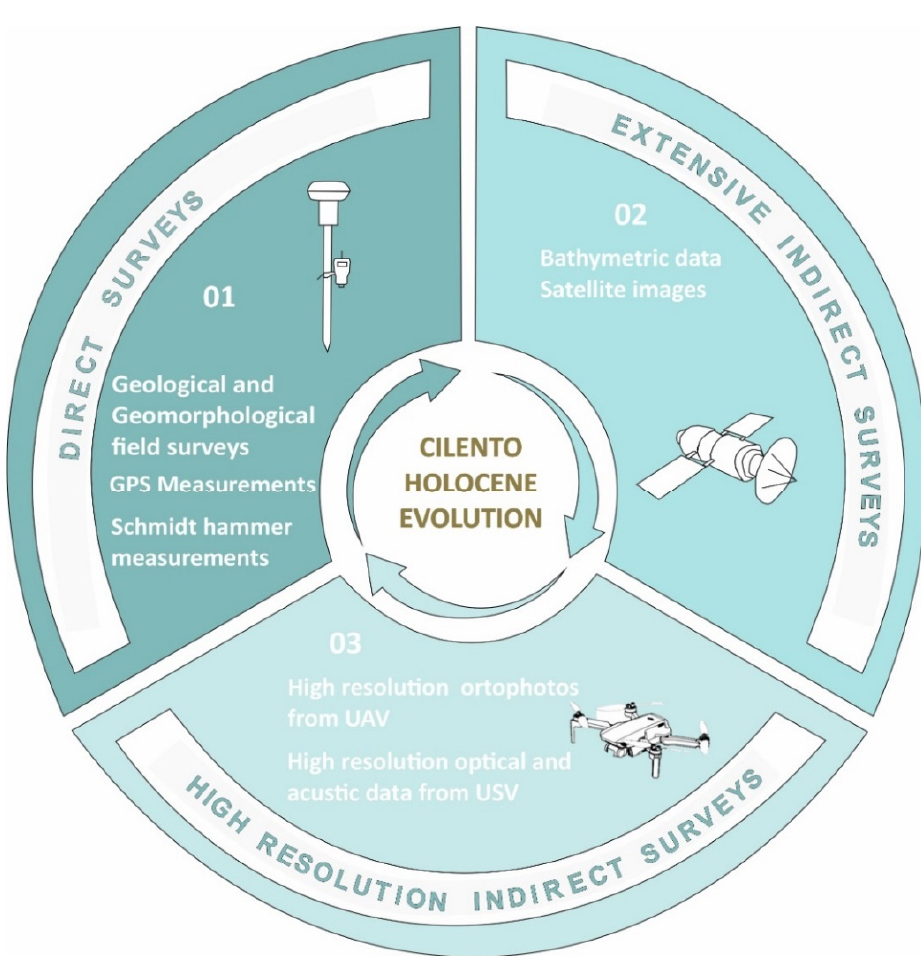
Figure 2 . Flowchart describing the methodological approach used in this research. Figure 2. Flowchart describing the methodological approach used in this